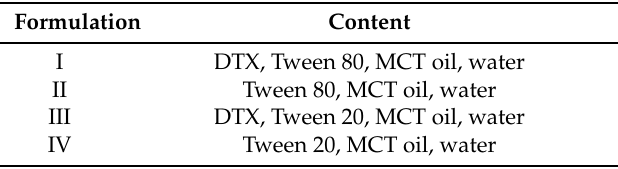
Table 1. Formulation Content.